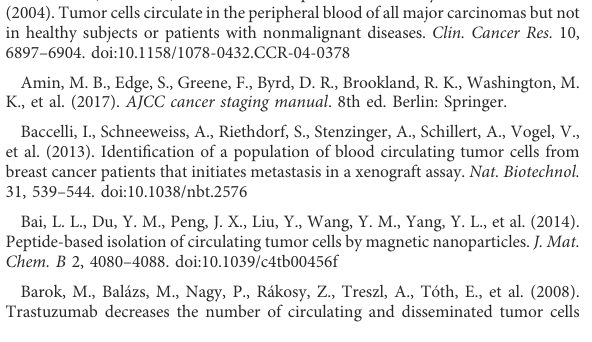
SUPPLEMENTARY FIGURE S1 Characterization of the Pep@MNPs. (A) Hydrodynamic diameters and zeta potentials of magnetic nanoparticles (MNPs) modi fi ed with or without a EpCAM recognition peptide (Pep@MNPs; unfunctionalized MNPs) from dynamic light scattering (DLS) analysis. Data were presented as means ± SD from 3 parallel samples. ** p < 0.01, unpaired Student ’ s t -test with Welch ’ s correction. (B) Transmissionelectronmicroscope(TEM)characterizationof Pep@MNPs and unfunctionalized MNPs. Scale bar: 200 nm. SUPPLEMENTARY FIGURE S2 Different EpCAM and HER2 expression levels among human breast cancer cell lines (SK-BR-3, MDA-MB-453, MCF-7, MDA-MB-468) and normal basal mammary epithelial cell line (MCF-10A). (A) Percentage (%) of stained cells with phycoerythrin (PE)-labeled anti-EpCAM or HER2 antibodies (Red) compared with isotype control (black) from fl ow cytometry analysis. (B) Western blot analysis. β -actin was chosen as internal reference protein. SUPPLEMENTARY FIGURE S3 HER2immunostainingonthecapturedbreastcancercellsbyPep@MNPs in a 106 U937 cells-contained system. (A) EpCAM and HER2 expression of human leukemia U937 cells from fl ow cytometry analysis. %, percentage of the cells positively stained with PE-labeled anti-EpCAM or HER2 (red) compared with isotype control (black). (B) Fluorescent graphs of the isolated breast cancer cells by Pep@MNPs in System 2 (1000 breast cancer cells + 106 U937 cells in 1 mL PBS) for each breast cancer cell line. The breast cancer cells were pre-stained with DAPI (blue, nuclei) and DiO (green, membrane), whereas U937 cells were only pre-stained with DAPI (blue, nuclei). The captured cells were then stained with Alexa Fluor ® 647-conjugated anti-HER2 (pink, HER2). Scale bar: 50 μ m. (C) The mean fl uorescent intensities (MFIs) from HER2 immunostaining on the captured breast cancer cells by Pep@MNPs in System 2. Fifty captured cells were analyzed for each breast cancer cell line.Dataarepresentedasmeans±SD.**** p < 0.0001,Student ’ st-test (unpaired) with Welch ’ s correction. (D) Correlation between the HER2 assessments of the captured cancer cells from System 1 (1000 breast cancer cells in 1 mL PBS) and System 2 (1000 breast cancer cells + 106 U937 cells in 1 mL PBS). Pearson ’ s correlation coef fi cient r = 0.9975 and